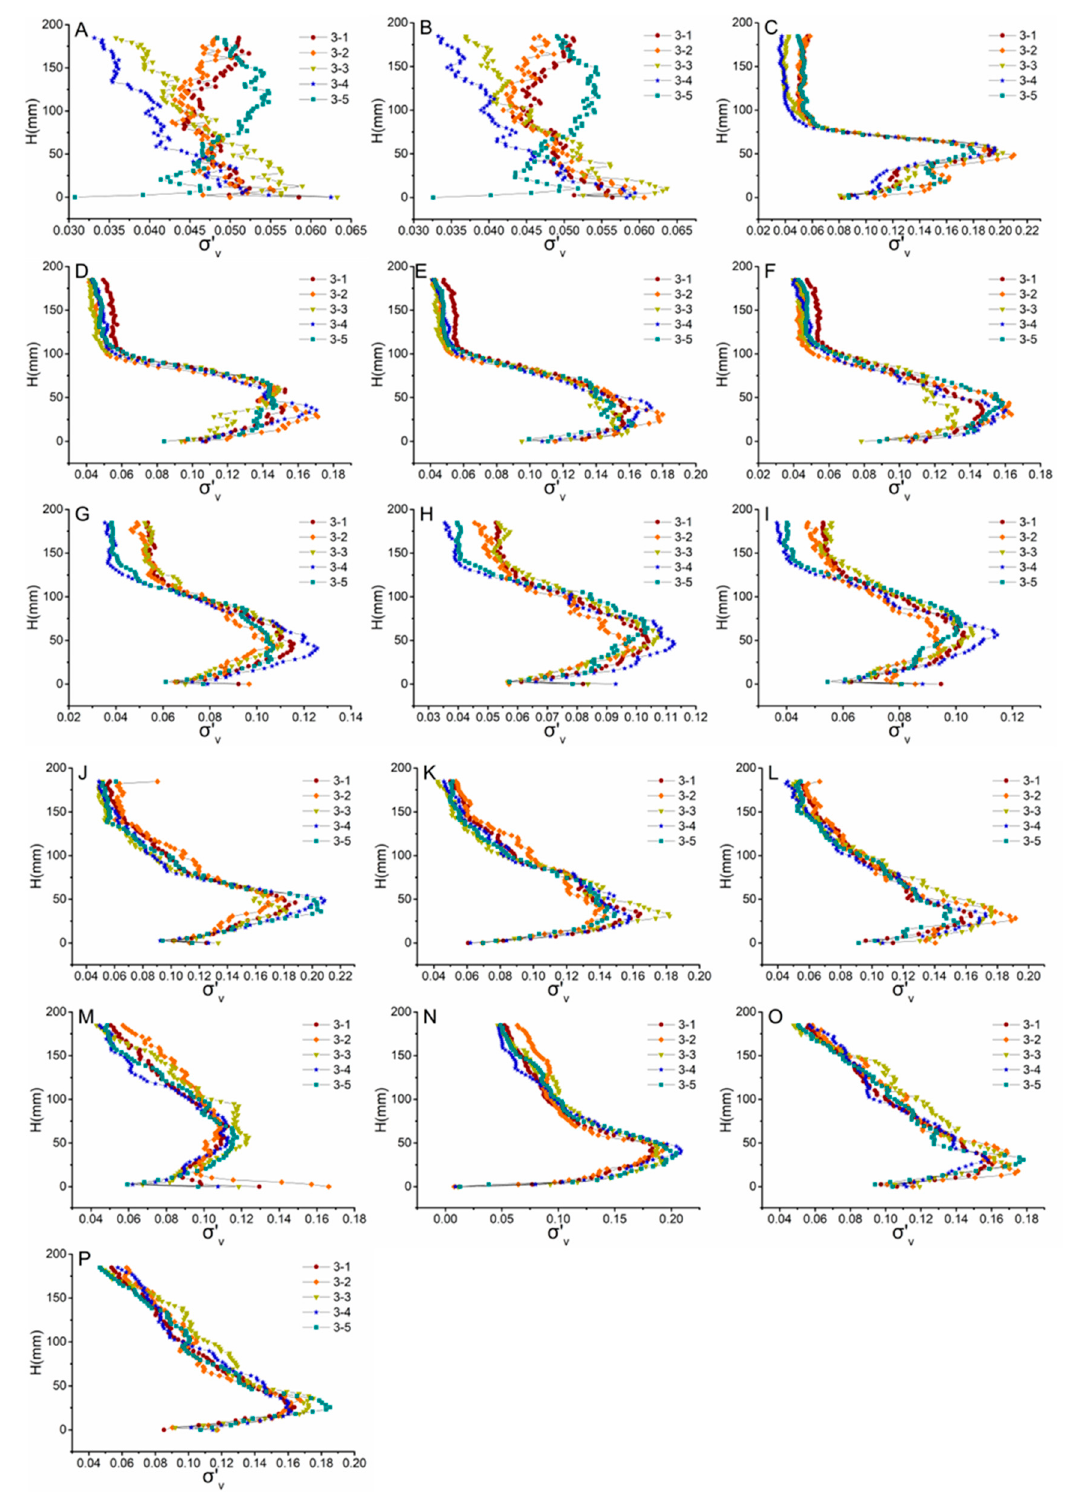
Figure 10. Vertical turbulence intensity for each section under geometrical configuration 3 and five different velocities tested. The subplots refers to the values measured at each of the 16 sections identified (A, B, C, D, E, F, G, H, I, J, K, L, M, N, O, P).